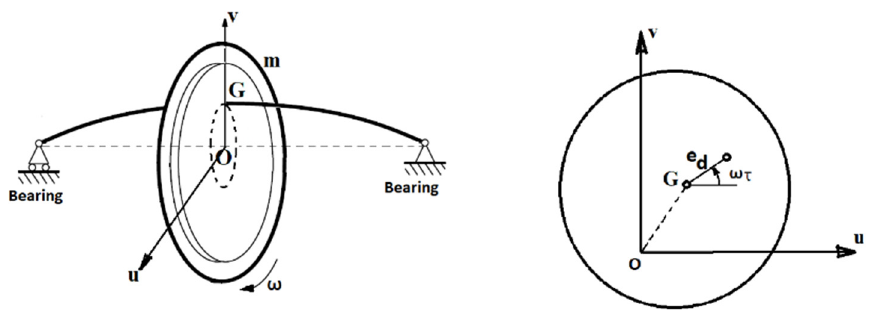
Figure 1. Jeffcott rotor system and coordinate system.